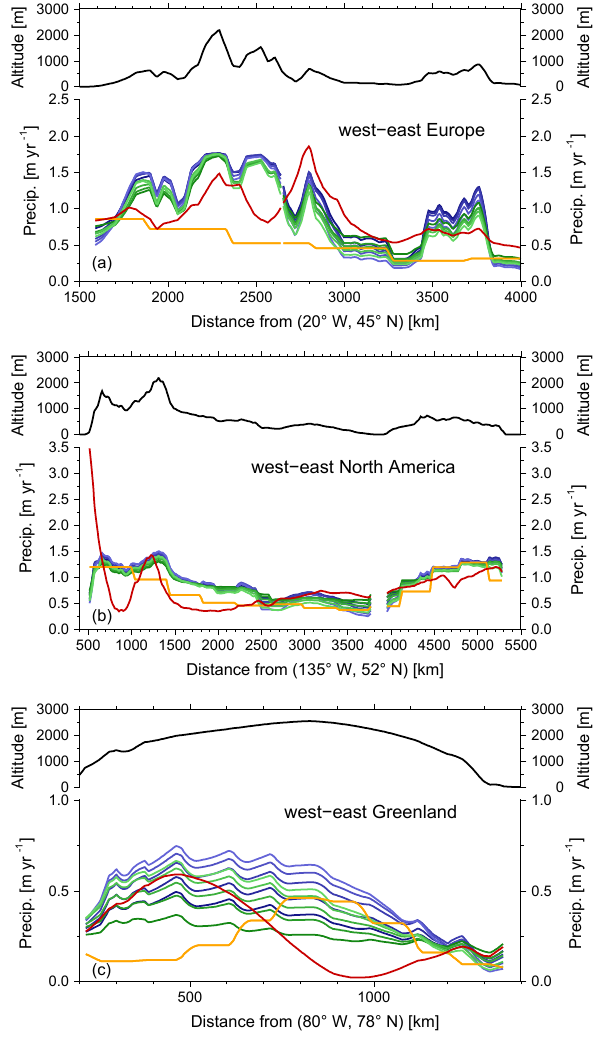
Figure 9. Transects for selected regions: Europe (a) , America (b) and Greenland (c) . The upper part of each panel shows the elevation along the transects. The lower part of each panel depicts the annual mean precipitation along the transects for: CRU CL-v2 (red), the standard i LOVECLIM (CTRL, orange), the i LOVECLIM including a downscaling with f s = 1 . 0 (blue), the i LOVECLIM including a downscaling with f s = 0 . 6 (green). The different shades of blue and green correspond to α min q ranging from 0.7 (dark) to 0.9 (light). The downscaling experiments presented in this figure use z q = 2000m and a change to z q = 3500m has only a very limited